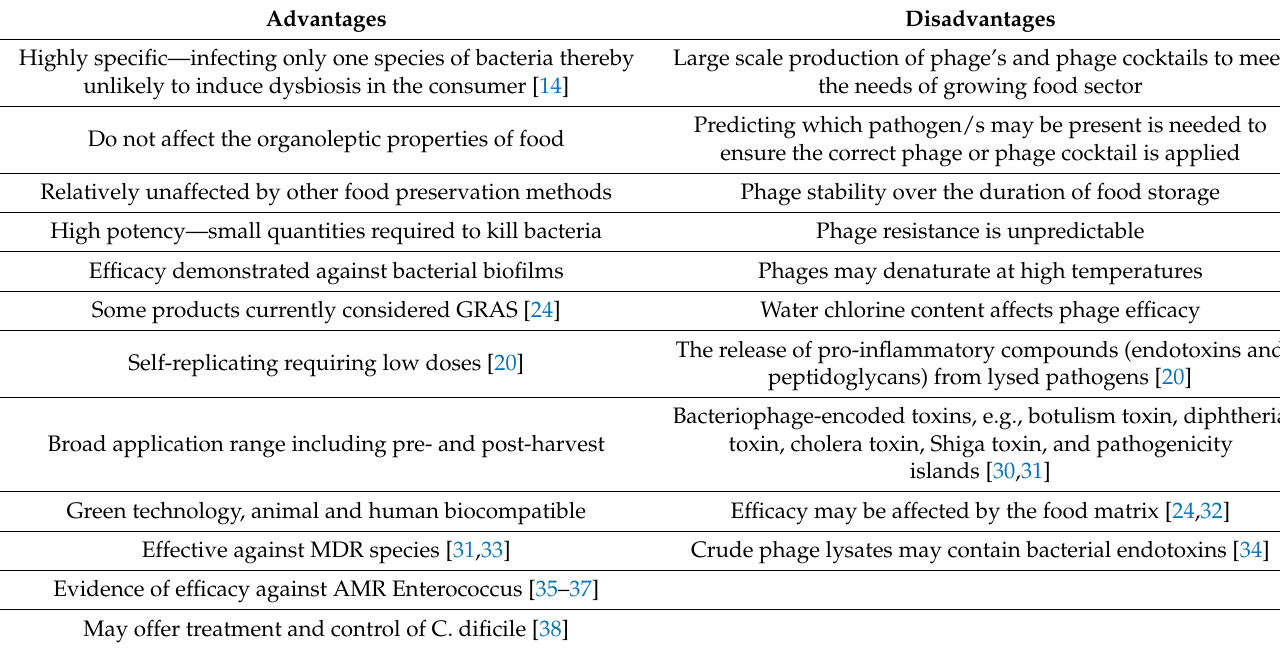
Table 2. Outlining the advantages and disadvantages of bacteriophages as food biocontrol